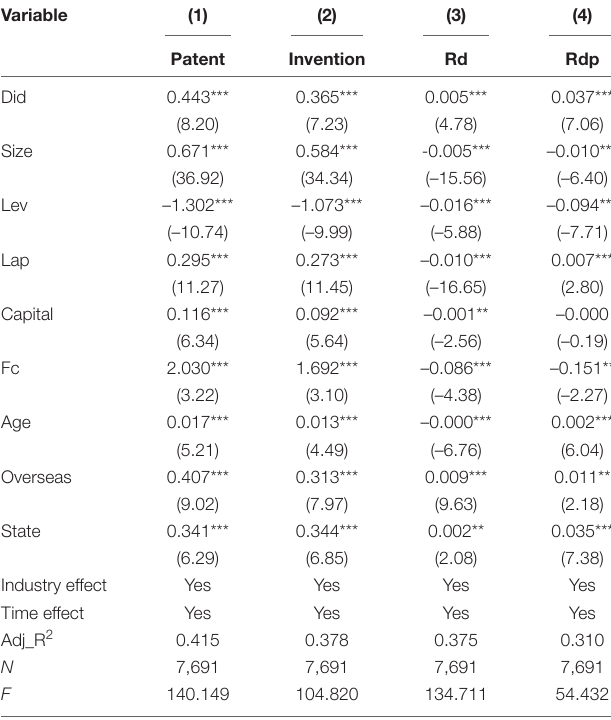
TABLE 5 | DID regression results. TABLE 6 | Regression results of PSM-DID analysis.